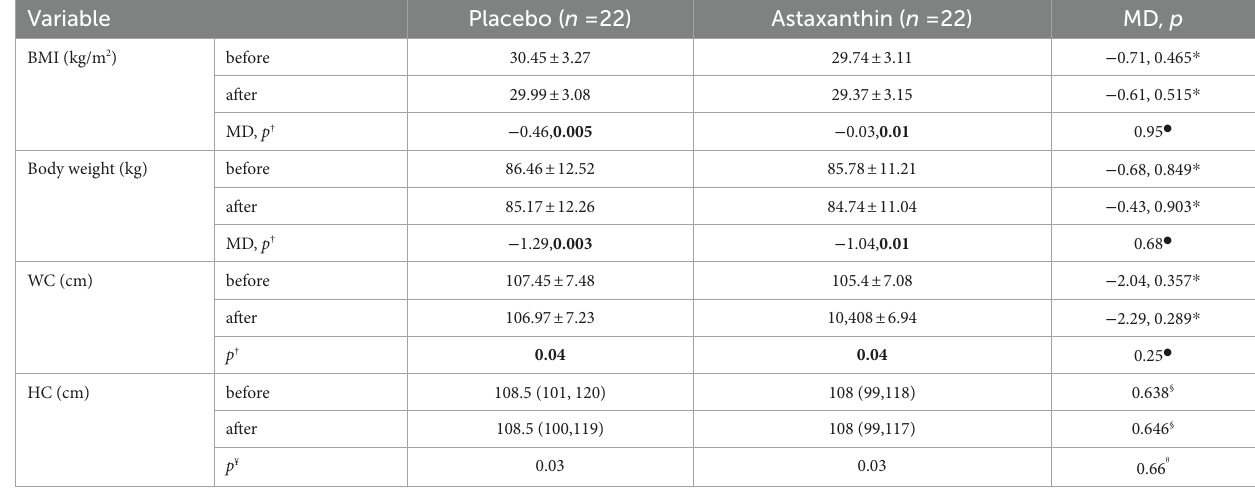
TABLE 2 Anthropometric